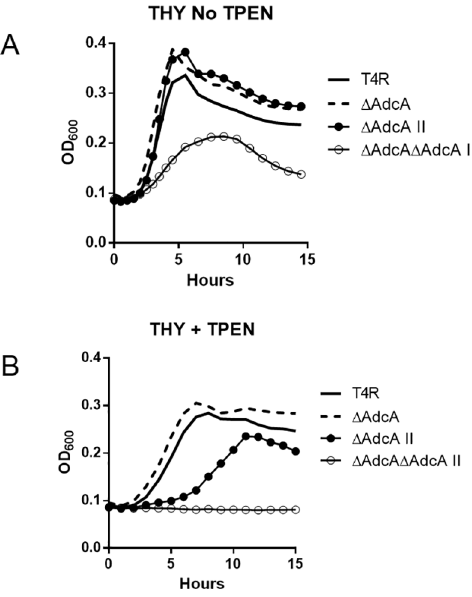
Fig 1. Effects of zinc concentration on growth of Adc mutants. A) Representative growth curve from three runs of T4R wild type and Adc mutants grown in THY media (pH6.5) in the absence (A) or presence (B) of the Zn-specific chelator TPEN (21 μ